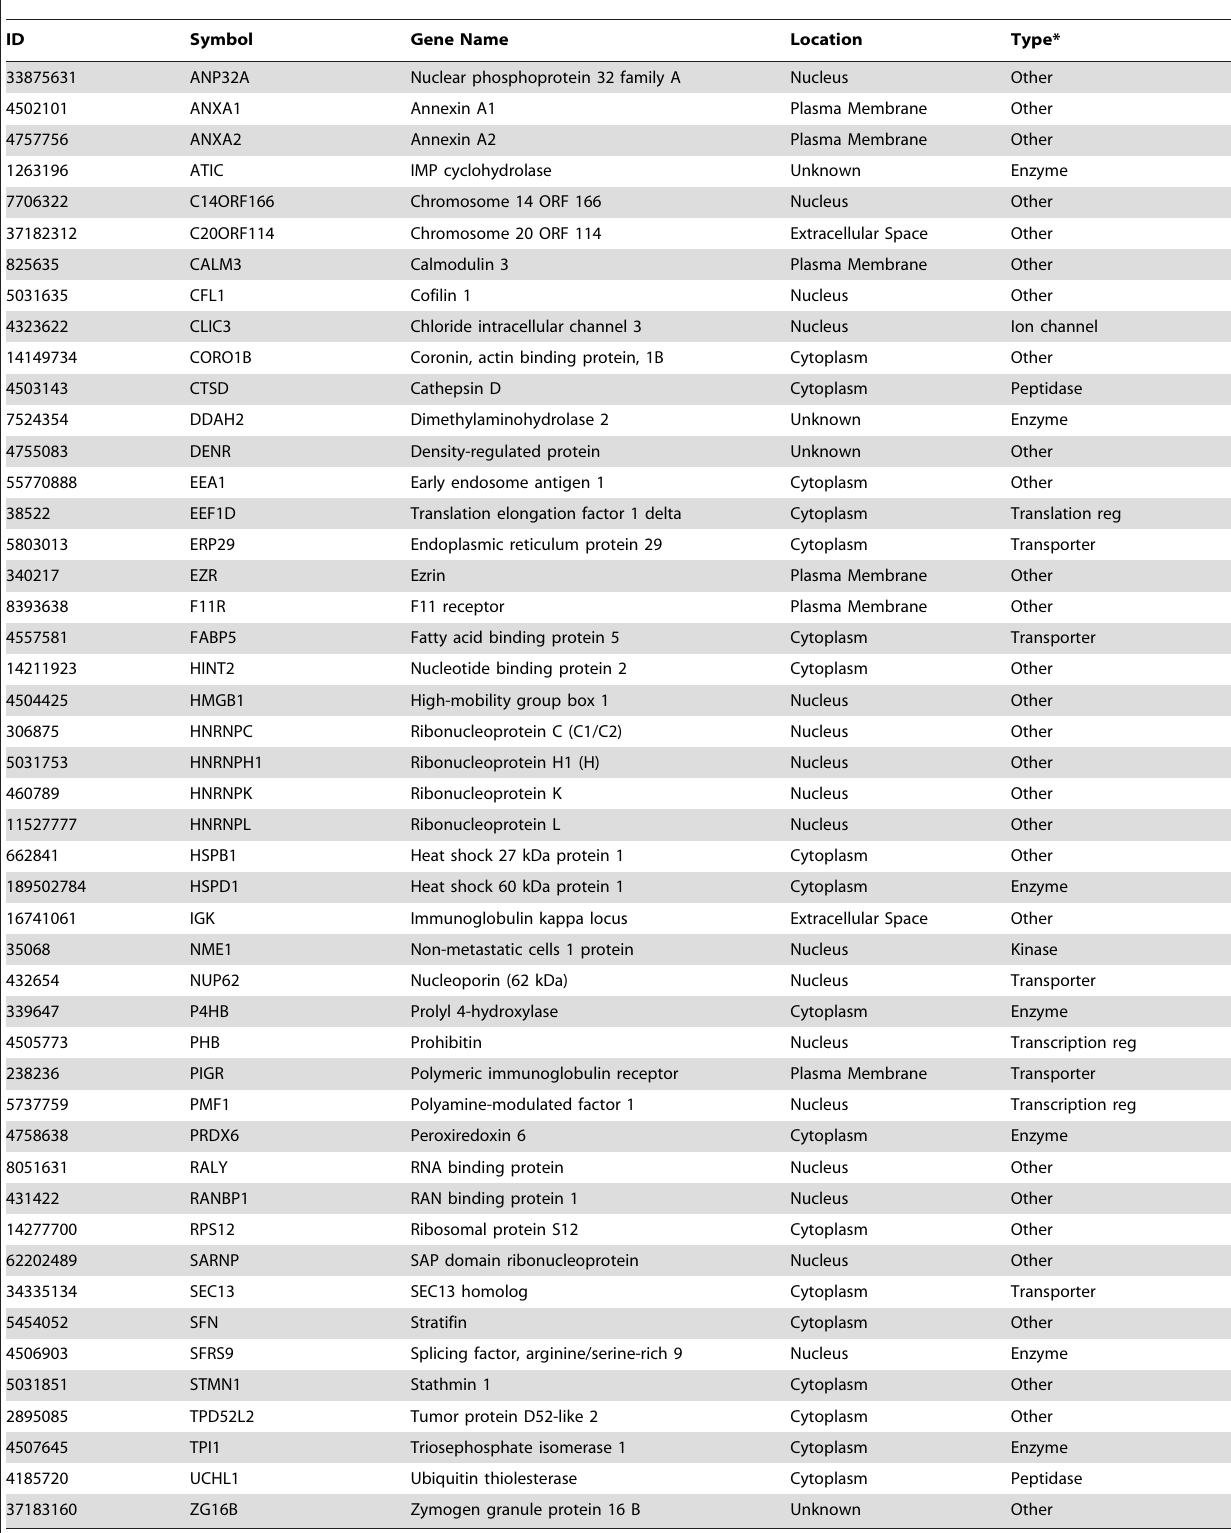
Table 4. Caco-2 cell proteins whose expression is downregulated in the presence of Campylobacter concisus UNSWCD.